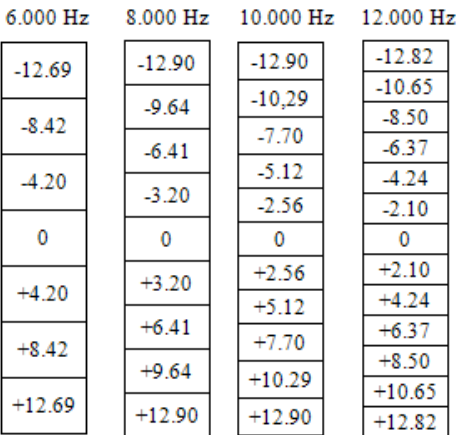
Figure 18. Steering angles vs. frequency.